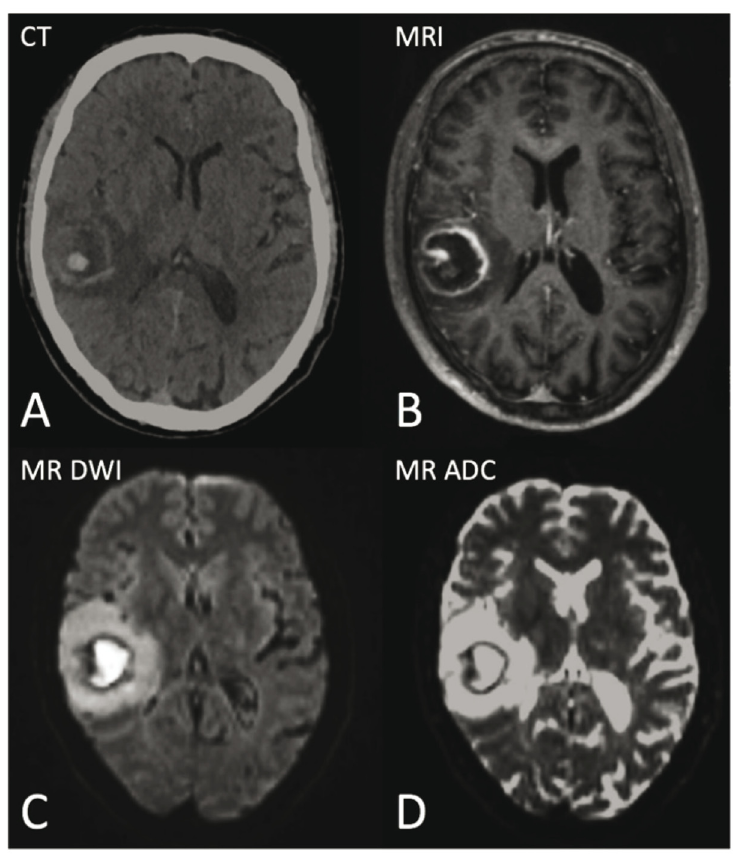
Figure 2. ( A ) Contrast-enhanced computed tomography (CT) scan and ( B ) gadolinium-enhanced magnetic resonance imaging (MRI) revealed a 2.7 × 2.9 × 3.2 cm ring-enhancing lesion within the right superior temporal gyrus with significant surrounding edema and a small area of central hemorrhage. ( C ) Diffusion-weighted imaging (DWI) and ( D ) apparent diffusion coefficient (ADC) MRI showed a diffusion- restricted core, supporting the differential diagnosis of acute cerebral